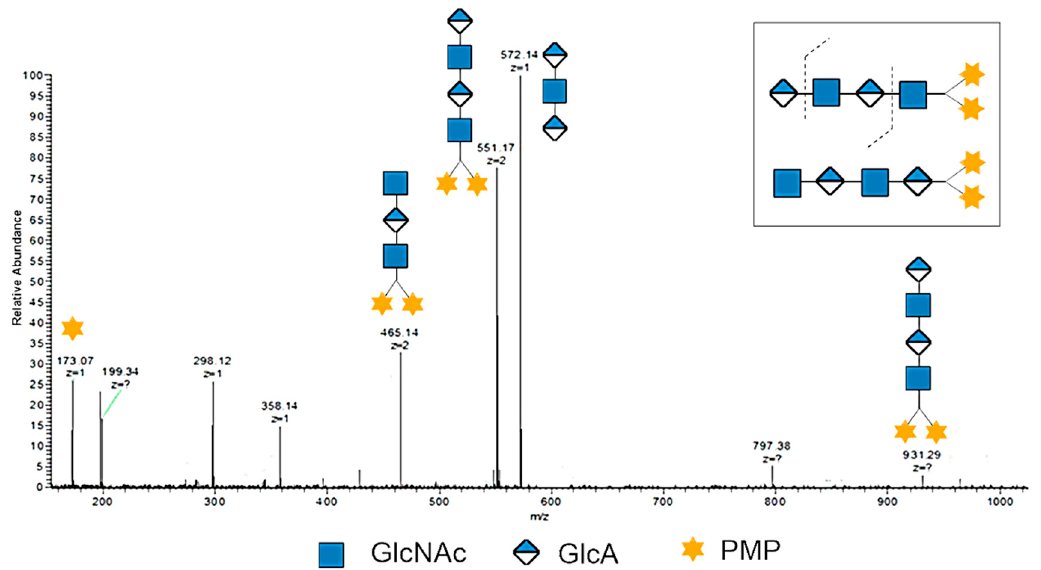
Figure 2. The negative-ion ESI-MS / MS profile of DP4 with labeled 1-phenyl-3-methyl-5-pyrazolone (PMP). The ion of m / z 551.17 was selected as the precursor for negative-ion ESI-MS / MS analysis.